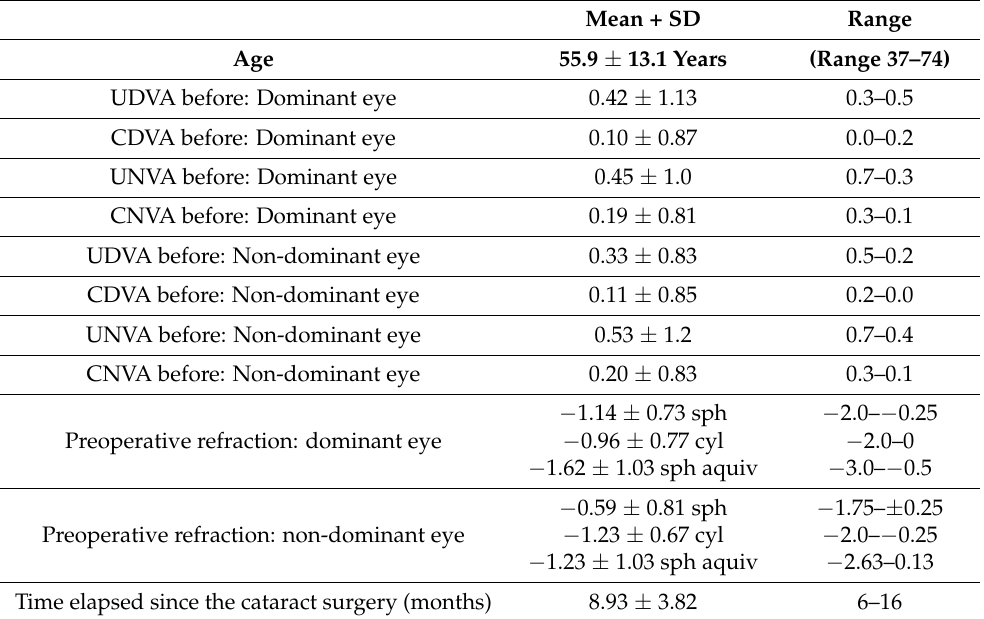
Table 1. Details regarding preoperative data prior to PresbyLASIK, inclusive preoperative refraction, visual acuity in logMAR, and time elapsed since cataract surgery in